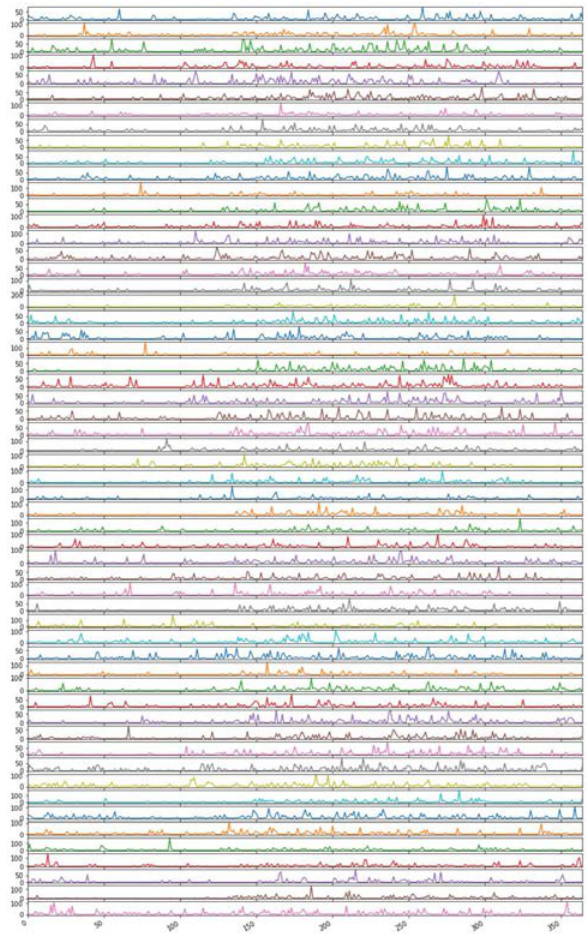
Figure 2. A stacked plot of Malaybalay Rainfall (1961-2017)